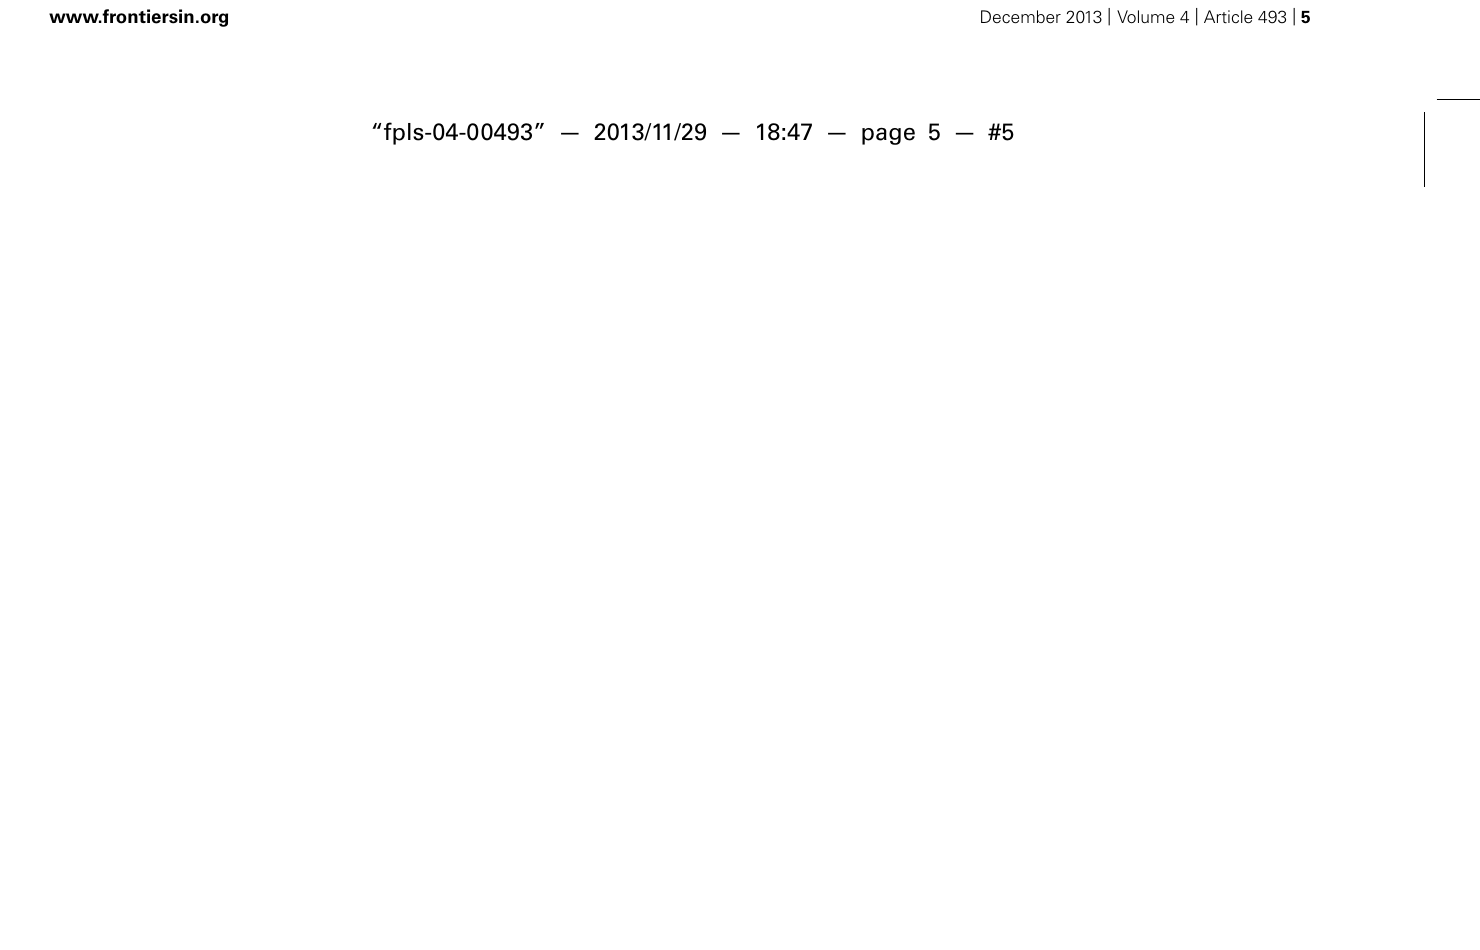
LEC2/TIP3-YFP/TIP1-RFP embryos (C,F) . Note that TIP1;1:TIP1;1-RFP is not expressed in seeds and is not detected on LV tonoplasts in older vegetative tissues ( D ; Feeney etal., 2013). Green color: TIP3;1-YFP. Vacuolar lumina are highlighted with neutral red (B,C) . In bottom images (D–F) red color is FM4-64 to label the plasma membrane and blue color is autofluorescence. Arrowheads in (C) indicate the plasma membrane. Bars = 10 μ